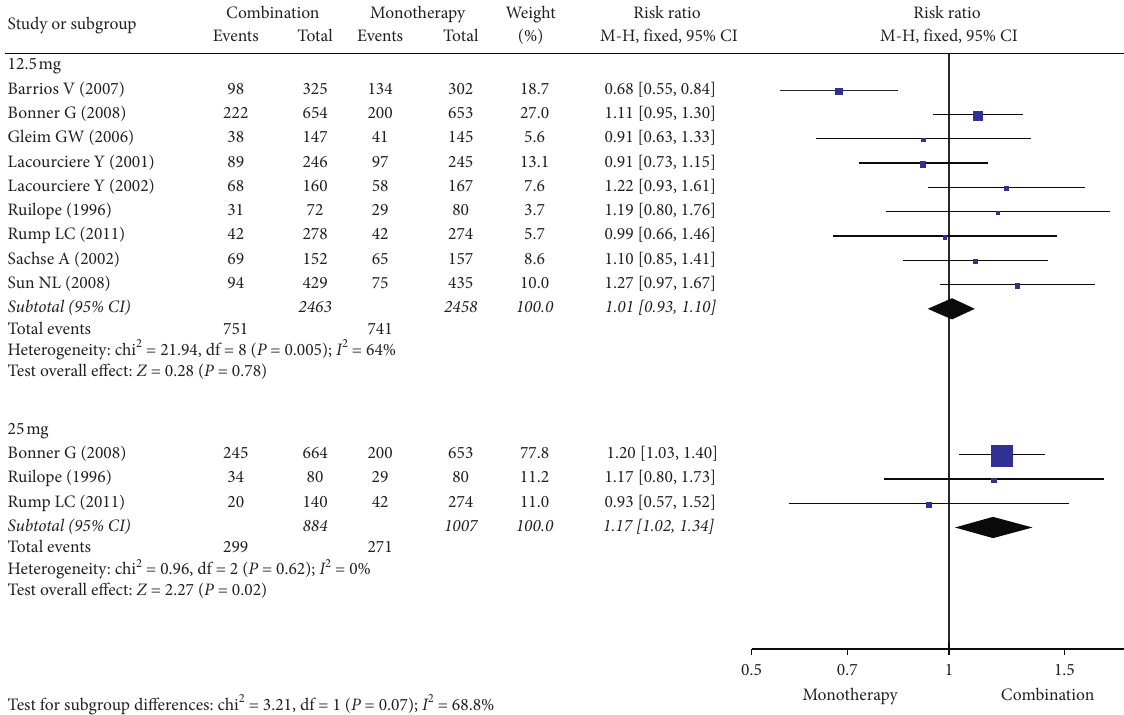
Supplementary Table 1: study characteristics of included studies. Supplementary Figure 1: summary of bias of the in- cluded studies by the Cochrane risk-of-bias tool. Supple- mentary Figure 2: funnel plot with Egger’s test for assessing the risk of publication bias. Supplementary Figure 3: forest plot for drug-related adverse events (AEs). Supplementary Figure 4: forest plot for severe adverse events (SAEs). Supplementary Figure 5: forest plot for discontinuation due to adverse events (AEs). ( Supplementary Materials )